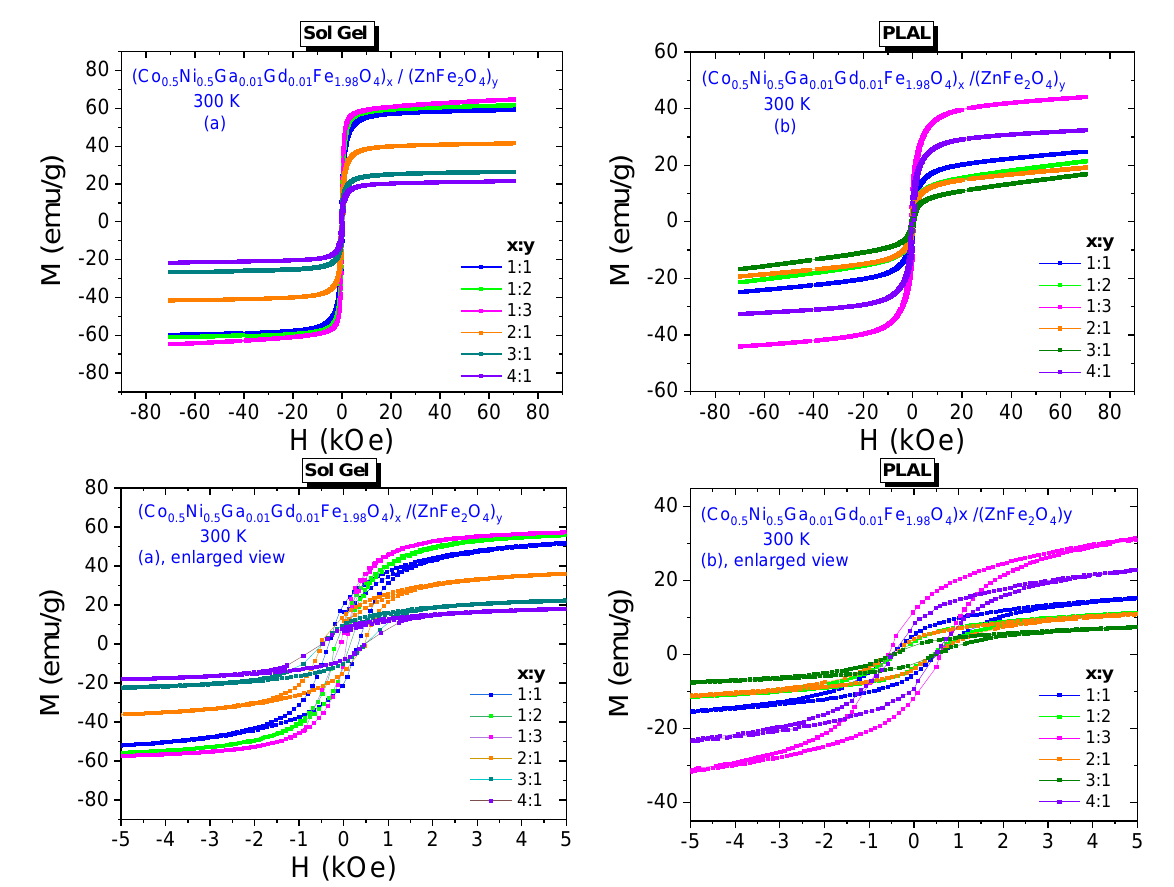
Figure 6. Room temperature (T = 300 K) M-H curves recorded from (Co 0.5 Ni 0.5 Ga 0.01 Gd 0.01 Fe 1.98 O 4 ) x /(ZnFe 2 O 4 ) y NCs synthe- sized by ( a ) sol-gel method ( b ) PLAL method, including enlarged views under them.